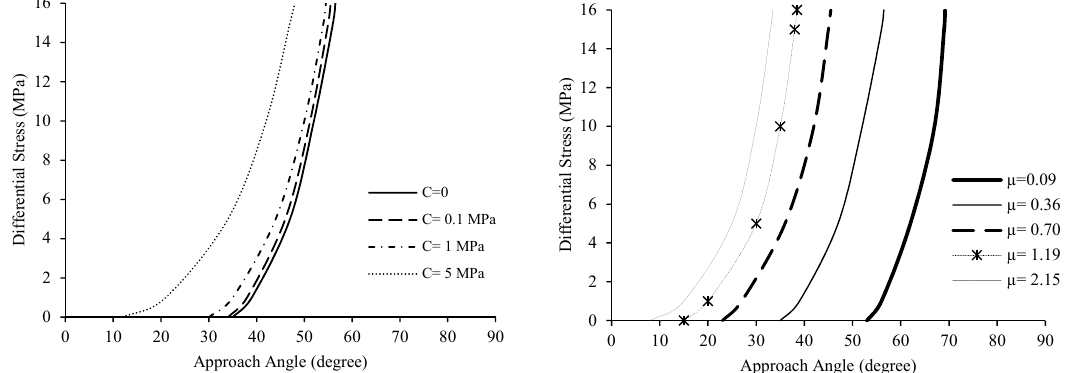
Figure 11. E ff ect of strength parameters of NF on crossed tendency based on Sarmadivaleh and Figure 11. Effect of strength parameters of NF on crossed tendency based on Sarmadivaleh and Rasouli [16] Rasouli [16] method